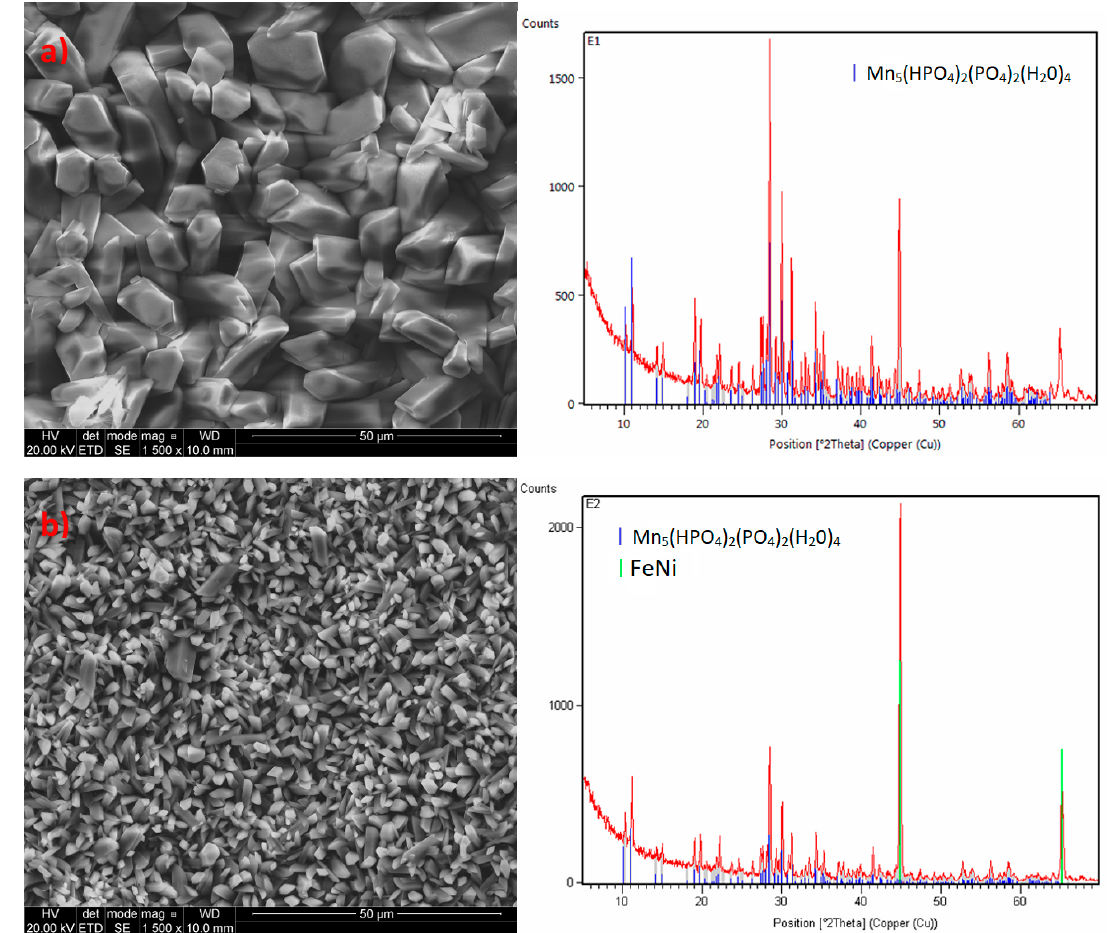
Figure 15. SEM photo and XRD pattern for samples modified with cadmium oxide ( a ) and samples modified with cadmium oxide and nickel compound ( b ).